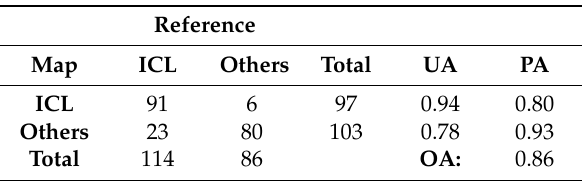
Table 4. Confusion matrices and accuracy statistics for integrated crop-livestock classification, validation on randomly selected control